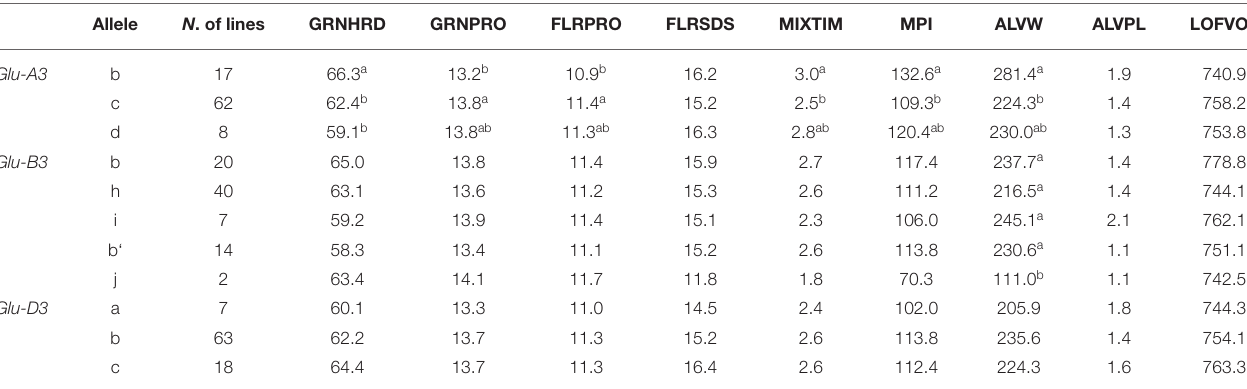
TABLE 4 | Comparison of least square means for the alleles at the Glu-3 loci.